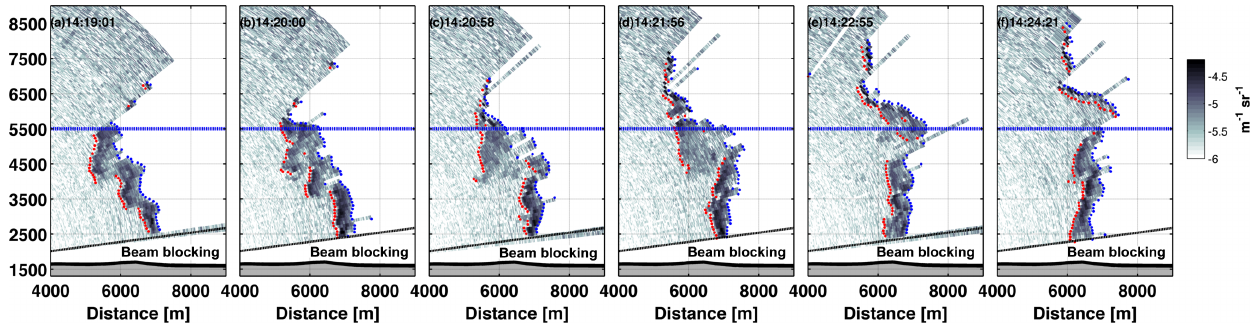
Figure 5. Plume rise sequence recorded by successive lidar RHI scans from 14:19 to 14:24PDT. The displayed data are the logarithmic attenuated backscatter coefficient (m − 1 sr − 1 ). The plume edge and attenuation points are shown in red and blue dots, respectively. Data beyond the attenuation point is shadowed (blank points). The dashed blue line indicates the condensation